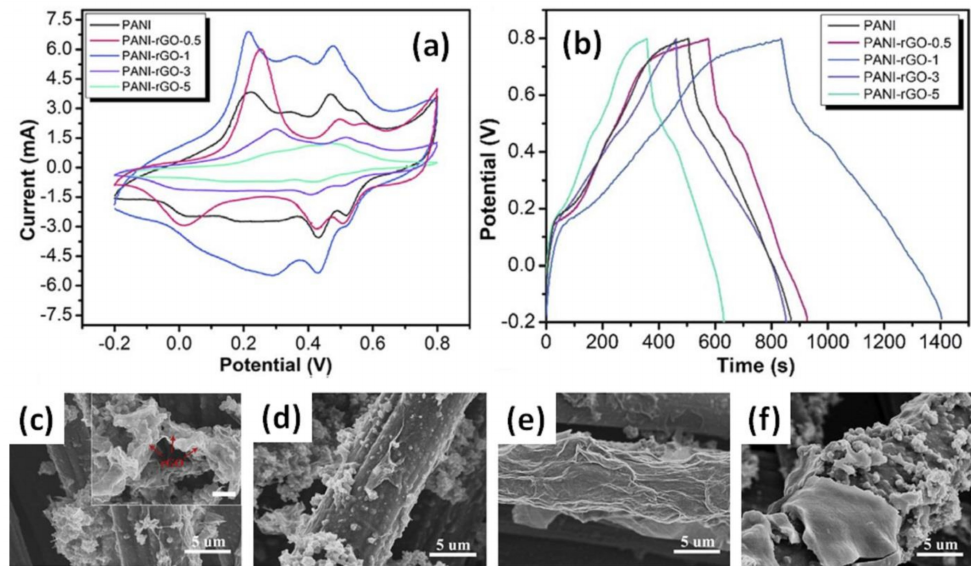
Figure 6. CV ( a ) and GCD ( b ) curves and microstructures of rGO/PANI/carbon woven fabric electrodes made with GO concentrations of 0.5 mg/mL ( c ), 1 mg/mL ( d ), 3 mg/mL ( e ) and 5 mg/mL ( f ). The inset in ( f ) is a zoom with a scale bar of 1 µ m. (Reprinted from [51], Copyright 2018, with permission of Elsevier).